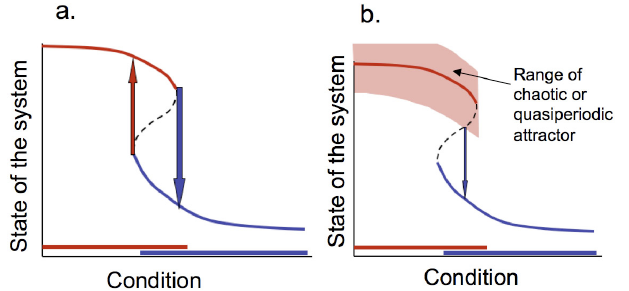
Fig. 5 . Relaxing the monotonic assumption of the relation between conditions and state of the system. The red and blue parts of the curve represent the location of stable points, and the red and blue lines near the abscissa represent the basins of attraction for the two stable point configurations, according to either red or blue.